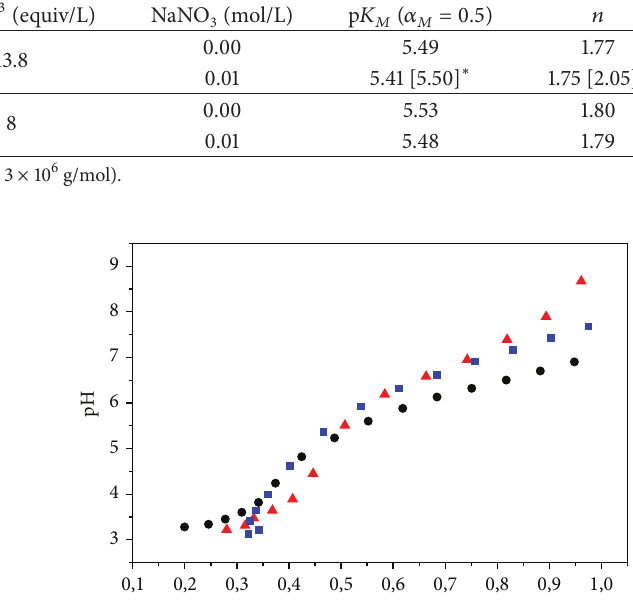
Table 1: Values of p 𝐾 𝑀 and 𝑛 for PAA/Cu(II) and HQ-PAA/Cu(II). Polymer